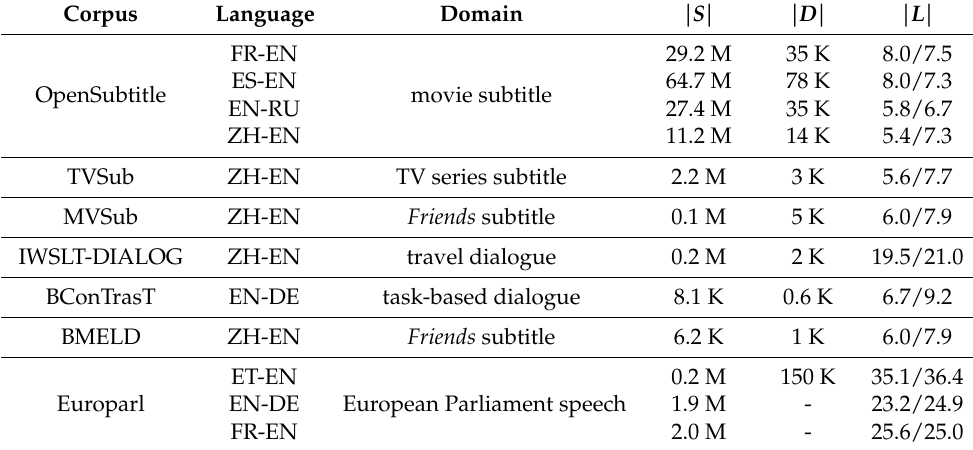
Table 1. Statistics of training corpora for dialogue machine translation. The details are the name of corpora, language pairs, domains, number of sentences ( | S | ), number of documents ( | D | ), averaged sentence length ( | L | ). K stands for thousand and M for